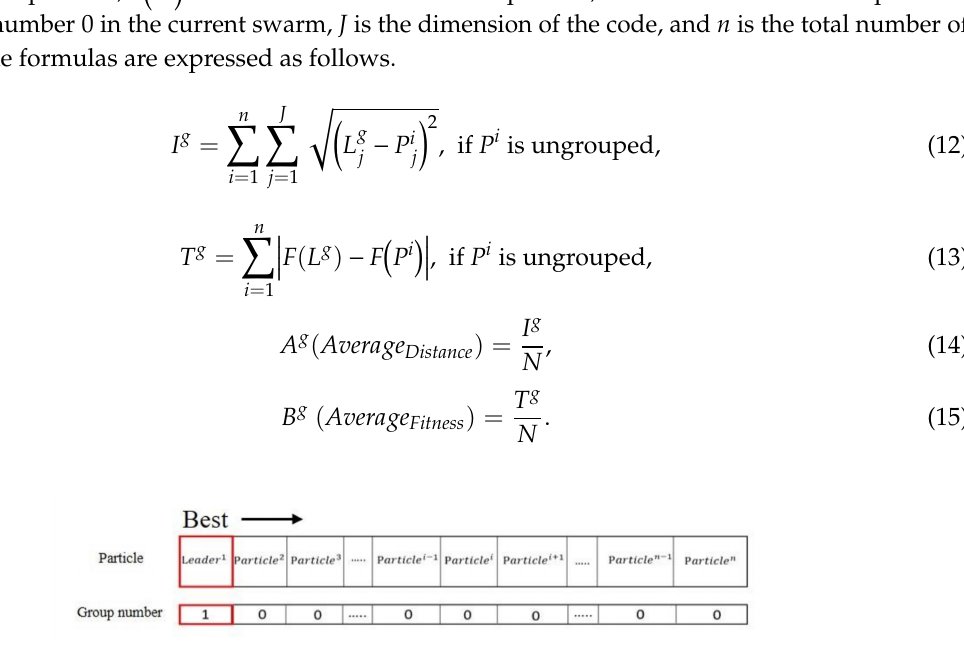
Figure 5. Leading diagram of the new group